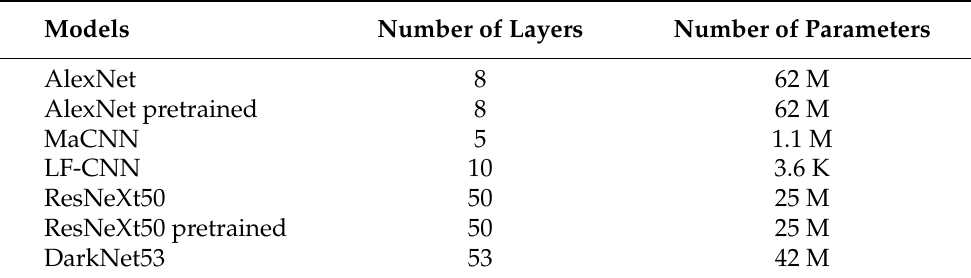
Table 1. Comparison between the different models in terms of number of layers and